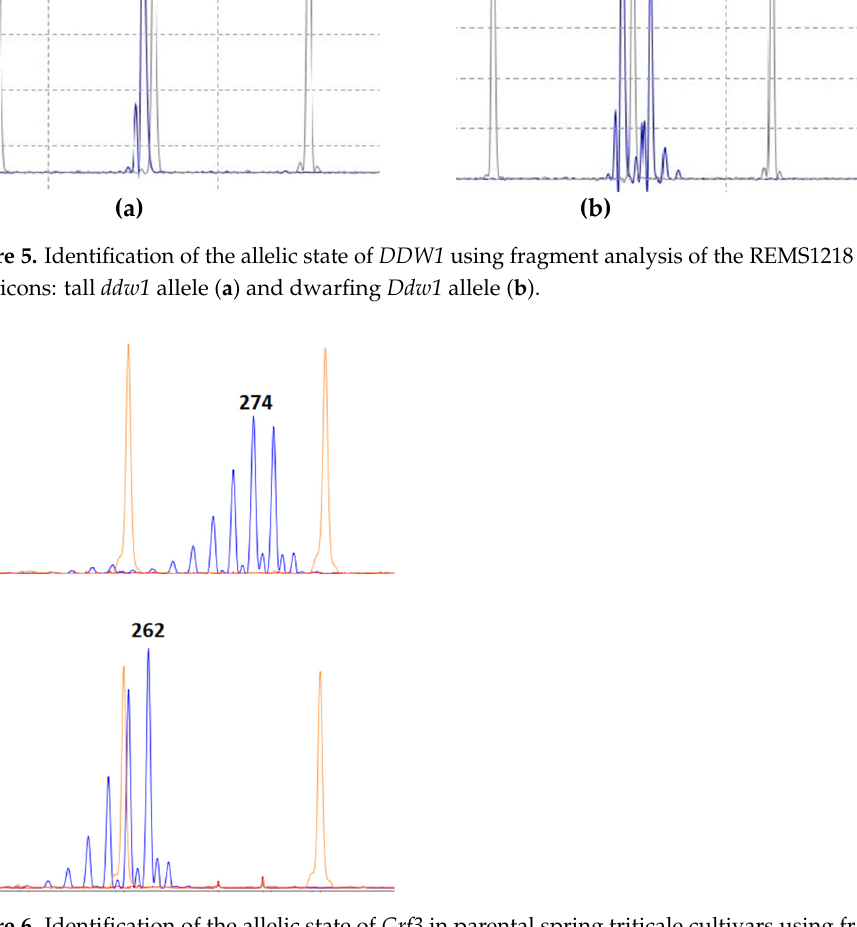
Figure 6. Identification of the allelic state of Grf3 in parental spring triticale cultivars using fragment analysis: Grf3 (274) in Dublet and Grf3 (262) in Hongor.